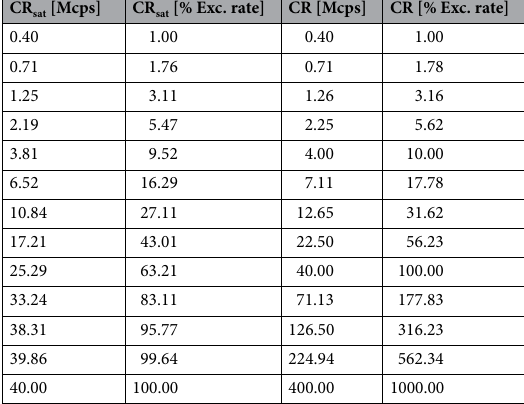
Table 1. CRs used for simulations before (CR sat ) and after (CR) correction (first and third columns). The percentage of the excitation rate is reported (second and fourth columns).